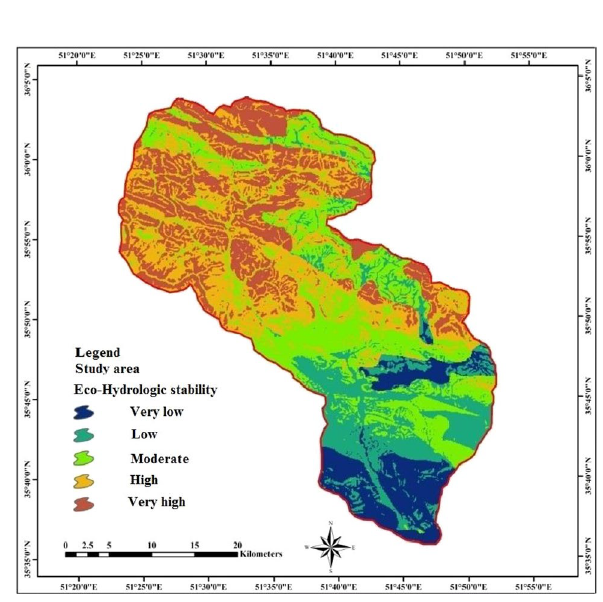
Fig. 3 Classified eco-hydrologic stability map